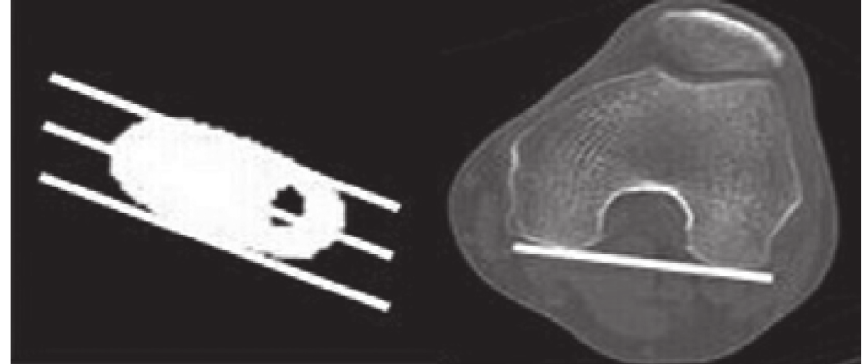
Figure 2: Stem rotation setting angle. The stem rotation setting angle is measured using the rotation axis of the stem from the anterior/ posterior stem in the CT horizontal section with reference to the posterior condylar axis.